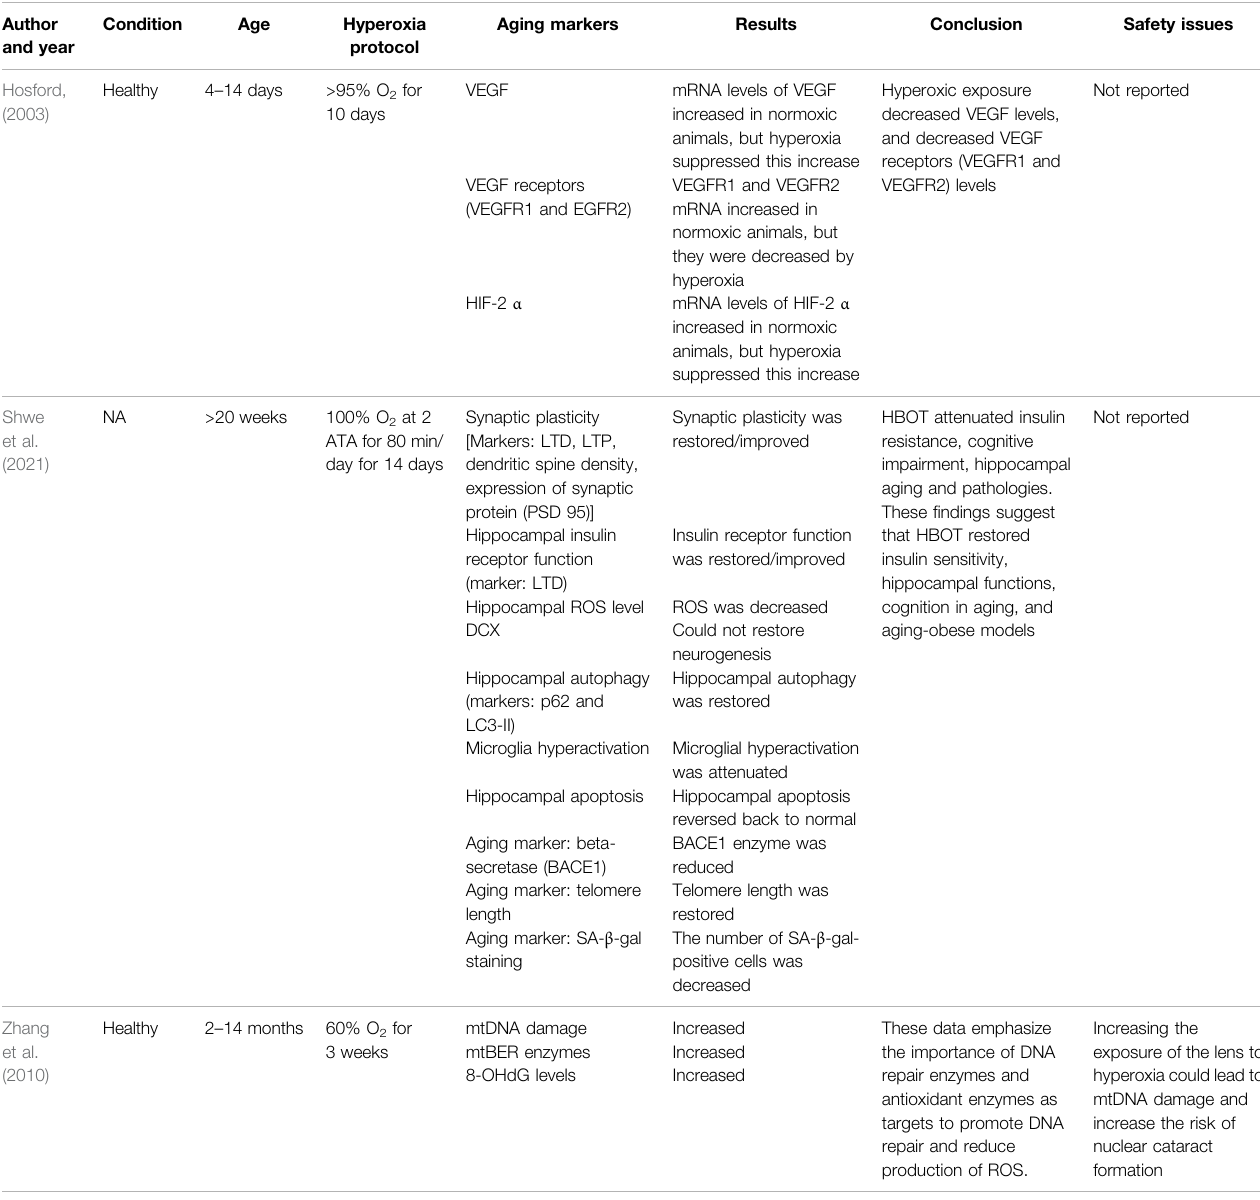
TABLE 3 | The effect of hyperoxia on aging markers in